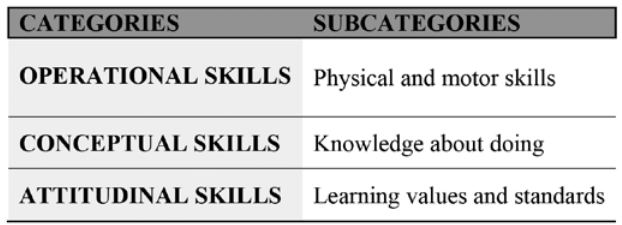
Figure 1: Category matrix of the Portuguese document.